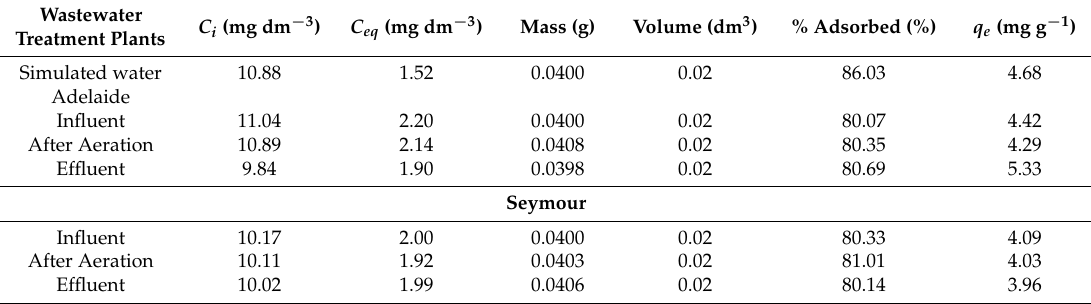
Table 9. Analytical data for real wastewater samples at pH 6.0, 200 rpm, 20 ◦ C, 0.040 g of adsorbent, 20 cm 3 of adsorbate for 4 h for Zn(II).